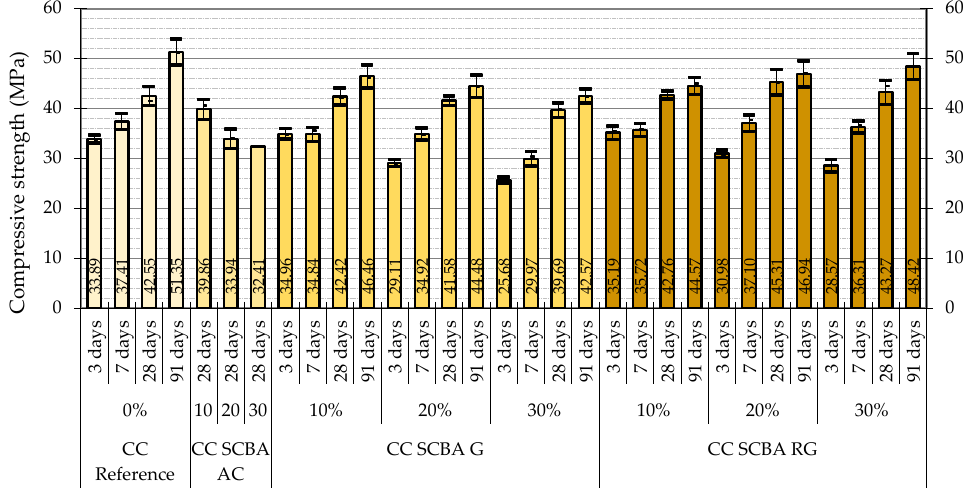
Figure 11. Compressive strength of mortars with a water/binder factor fixed in volume.